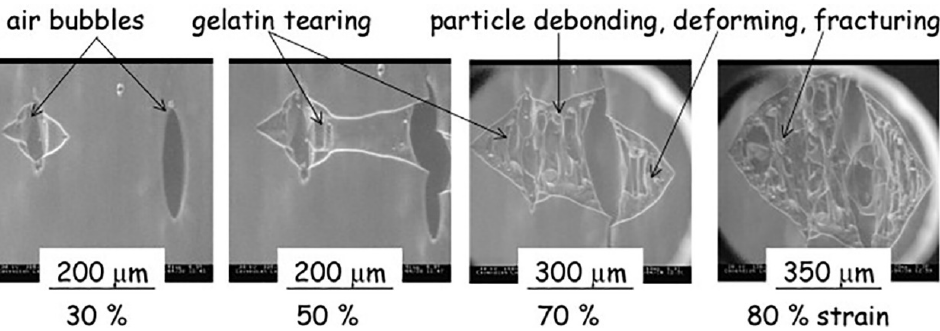
Figure 8. Environmental scanning electron microscope (ESEM) micrographs following the continuous crack propagation on the surface gelatin/maltodextrin sample [71]. (Reprinted with permission from crack propagation on the surface gelatin / maltodextrin sample [71]. (Reprinted with permission from Rizzieri et al., 2003.) Rizzieri et al.,